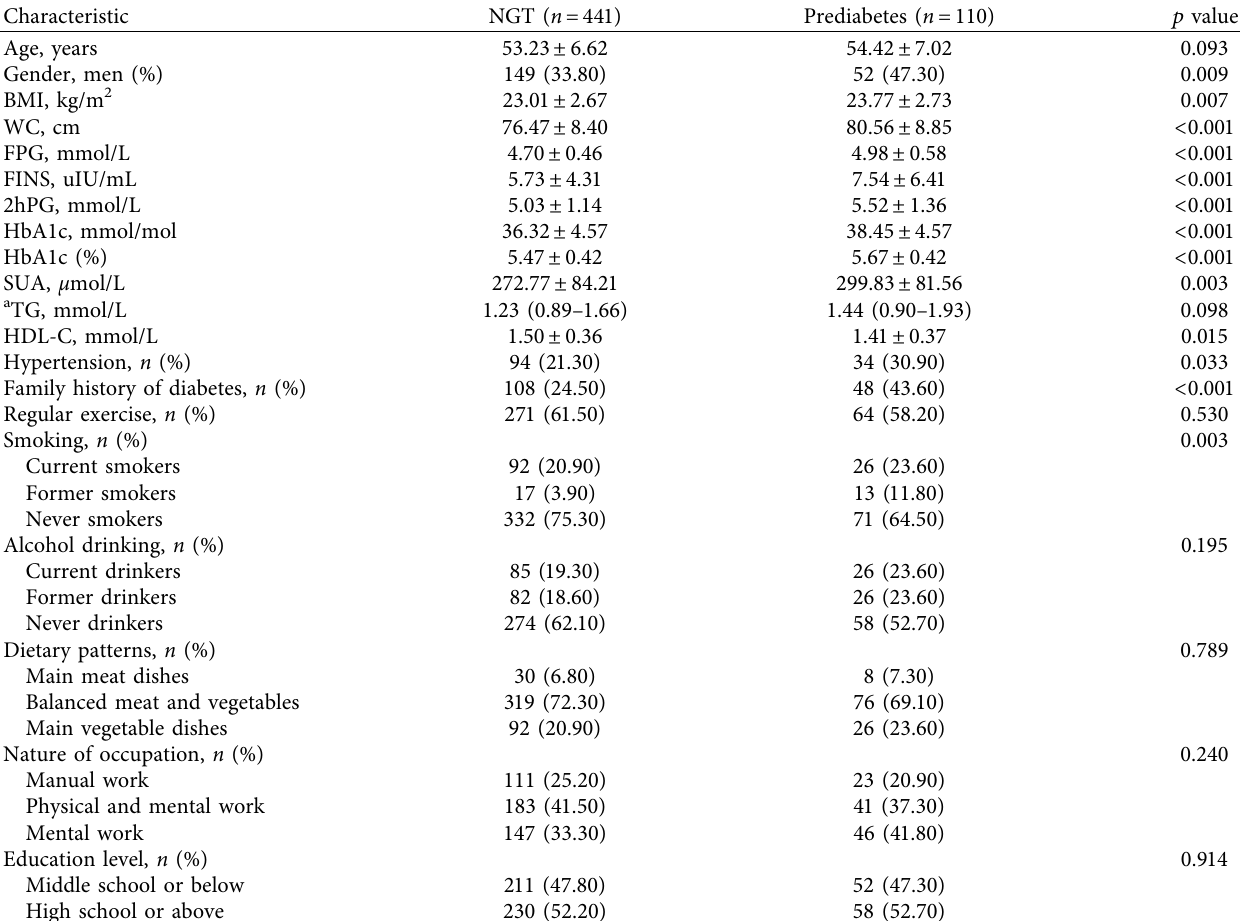
Table 1: Basic characteristics of study participants categorized by glucose metabolism.